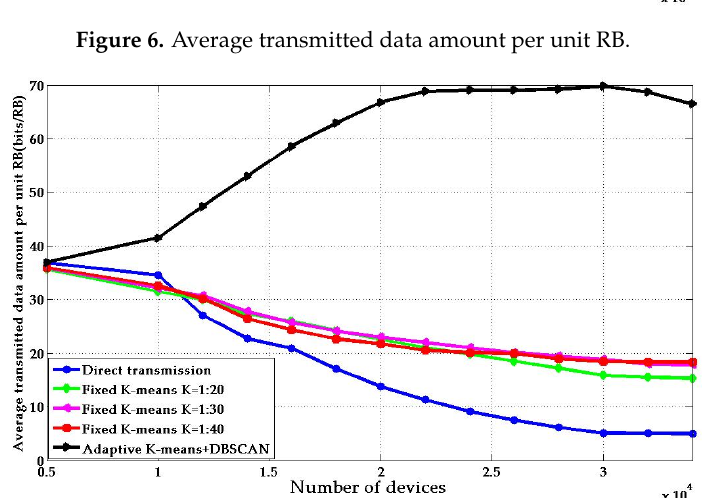
Figure 6. Average transmitted data amount per unit RB. Figure 7. The throughput of the base